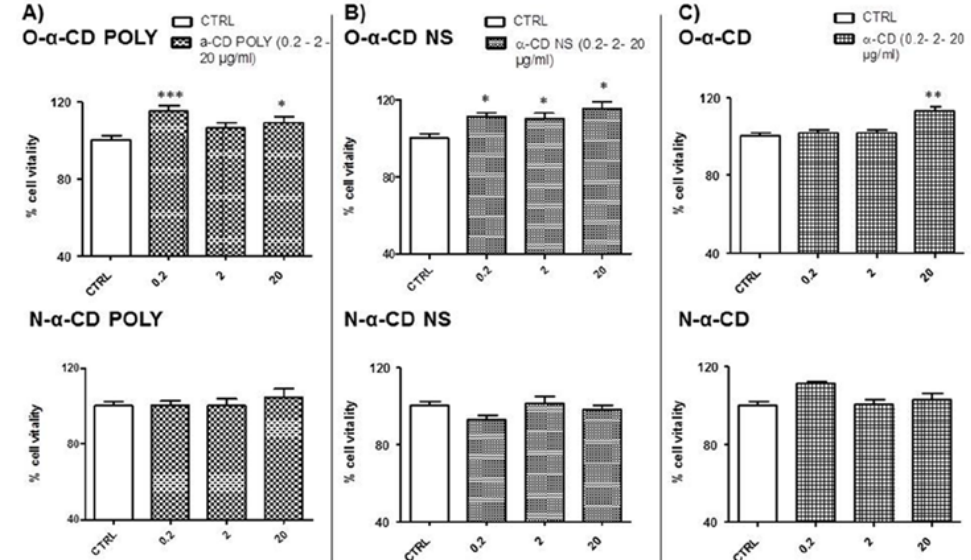
Figure 6. Dose–response in normoxic conditions. ( A ) Treatment with O-α-CD POLY (0.2, 2, 20 µg/mL) and N-α-CD POLY (0.2, 2, 20 µg/mL); ( B ) Treatment with O-α-CD NS (0.2, 2, 20 µg/mL) and N-α-CD NS (0.2, 2, 20 µg/mL); ( C ) Treatment with O-α-CD (0.2, 2, 20 µg/mL) and N-α-CD (0.2, 2, 20 µg/mL), compared to the untreated control group (CTRL). Data were normalized to the mean value in control conditions and expressed as a